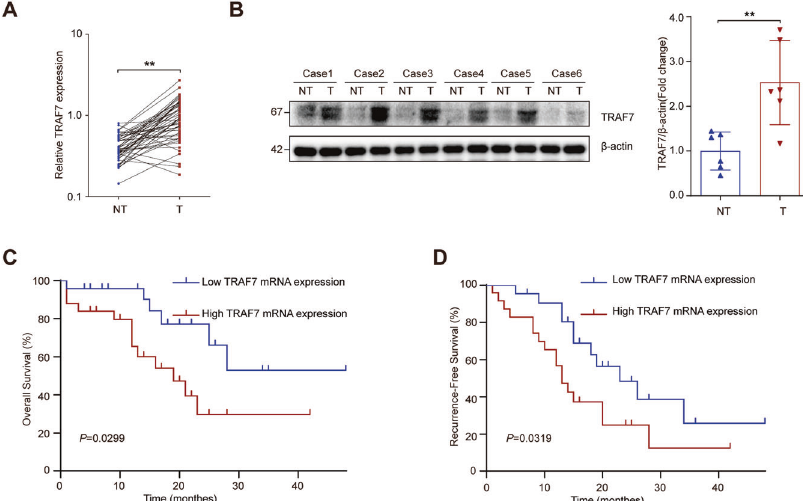
Fig. 1 TRAF7 was upregulated in HCC. A TRAF7 mRNA expression level in HCC tissues and adjacent non-tumor tissues of 49 HCC patients. NT: Non-tumor tissue, T: Tumor tissue. n = 49. B Western Blot analysis of TRAF7 expression in adjacent non-tumor and HCC tissues. n = 6. C , D Kaplan- Meier analysis of overall survival (OS) and recurrence-free survival (RFS) based on TRAF7 expression levels in 49 patients with HCC. ** p < 0.01. Table 1. Clinical characteristics of 49 HCC patients according to TRAF7 expression level.